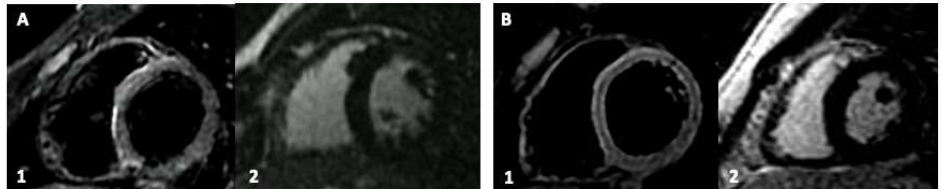
Figure 2. Cardiac magnetic resonance (CMR) imaging at the follow-up after medical treatment of young patients with vaccine-related myocardial involvement. Panel ( A , B ): Participants with previous inferolateral myocardial involvement. Sub-Panel 1, Short-Tau Inversion Recovery (STIR) images for myocardial edema detection. Sub-Panel 2, late gadolinium enhancement (LGE) images.